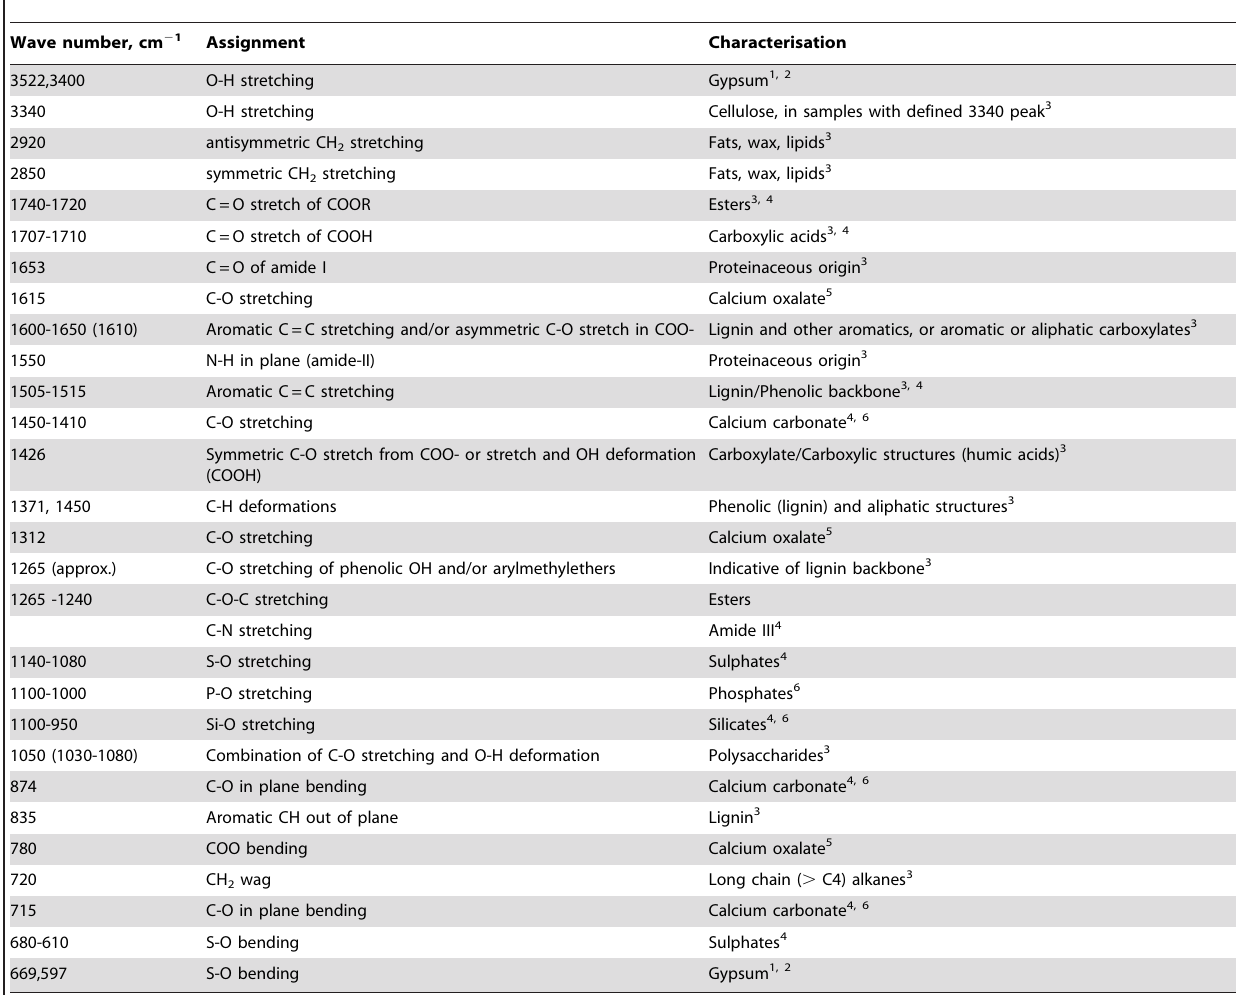
Table 3. Frequencies and assignments of the main peaks identified in the analysis of FTIR spectra.